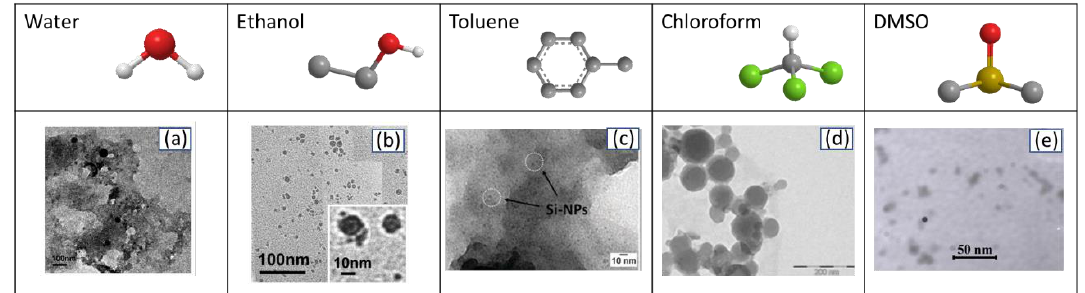
Figure 3. Summary of the silicon-based nanomaterials obtained by laser ablation of in different solvents: ( a ) water, ( b ) ethanol (Reproduced with permission from [71]. ACS Publications, 2009), ( c ) toluene (Reproduced with permission from [72]. Royal Society of Chemistry, 2012), ( d ) chloroform (Reproduced with permission from [73]. ACS Publications, 2011), and ( e ) dimethyl sulfoxide (DMSO) [71]).